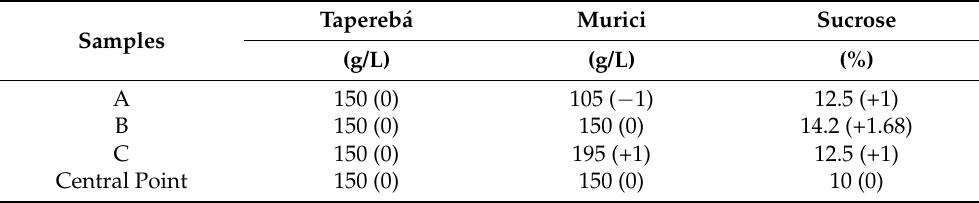
Table 5. Formula optimization uncoded and coded for murici and tapereb á